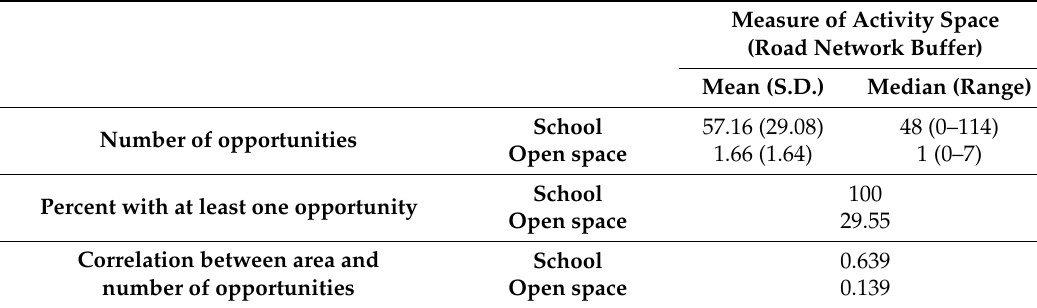
Table 5. Access to opportunities for road network